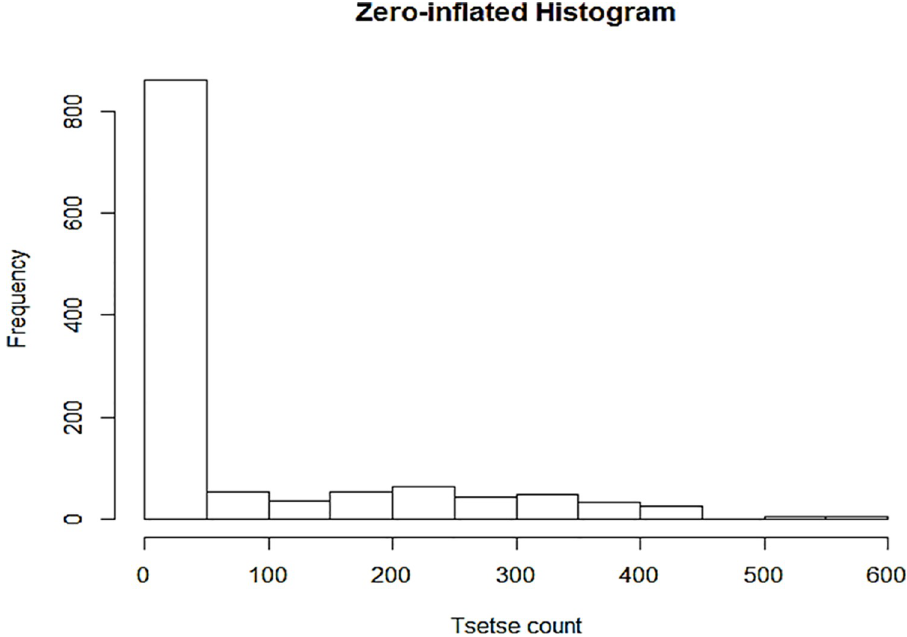
Fig 6. Frequency histogram showing number of tsetse flies at all locations in Uganda–a case of zero-inflation and over-dispersion. This is an output of the tsetse data exploration performed using R-tool.